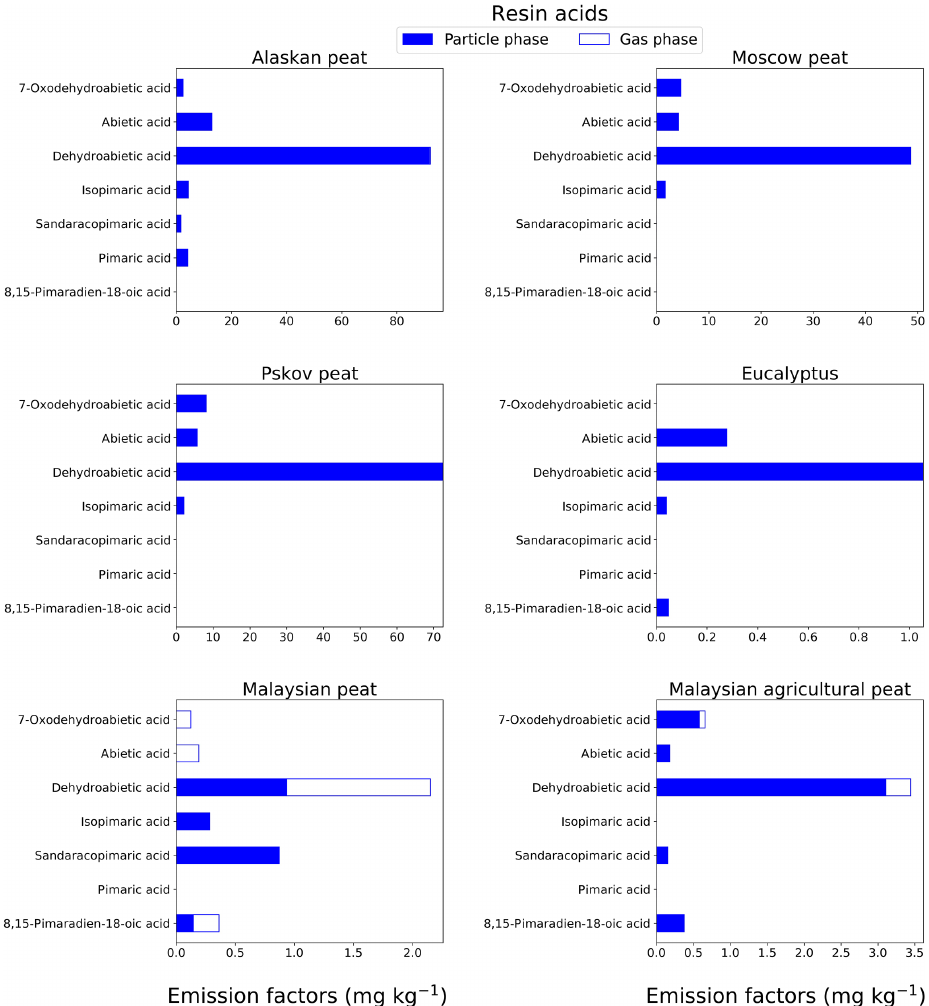
Figure 6. EFs of resin acids in both the particle phase (solid bars, filter samples) and gas phase (open bars, XAD samples) from fresh biomass-burning emissions for six different biomass types. As in prior cases, we did not burn fuels in replicates, and the standard-deviation (SD) values were calculated based on replicate analysis of similar fuels (with same experimental conditions) from our previous campaigns (Yatavelli et al., 2017), where SD varies between 9.7% and 15% for resin